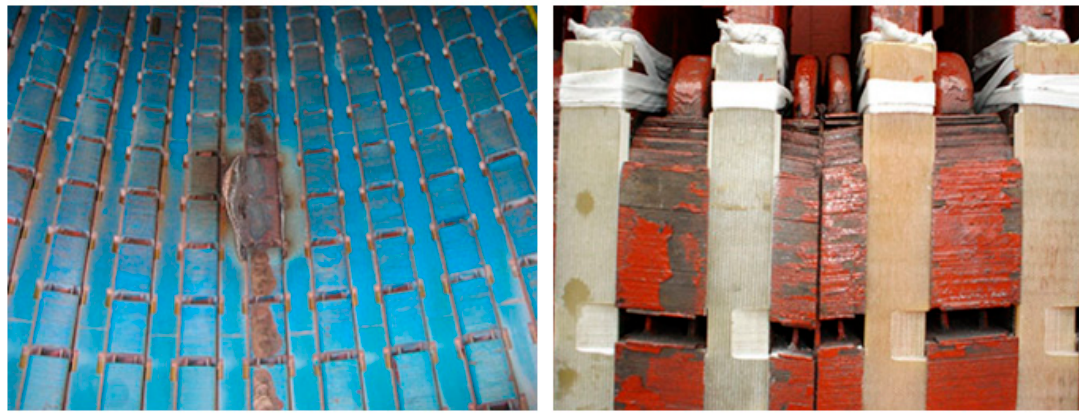
Figure 4. Damaged internal windings of the generator .